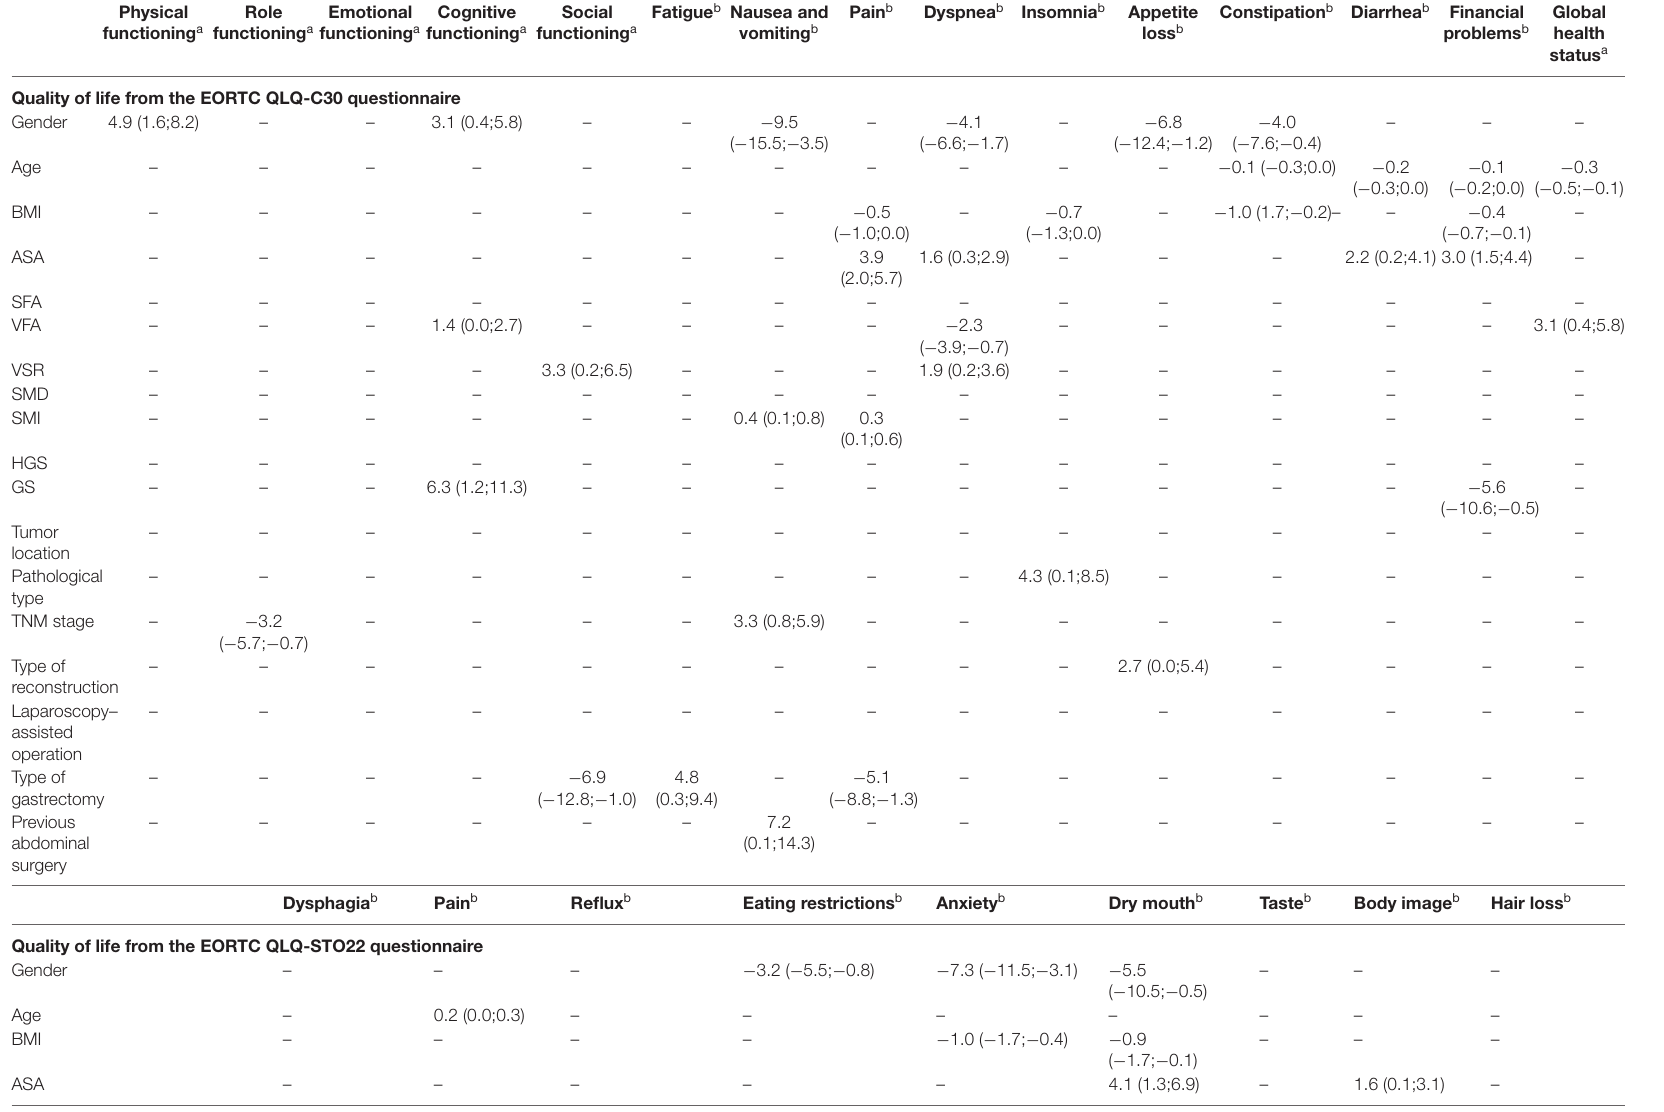
TABLE 4 | Multivariable linear regression model on quality of life, symptom scales, and functional scales from EORTC QLQ-C30 and QLQ-STO22 for 3 months after